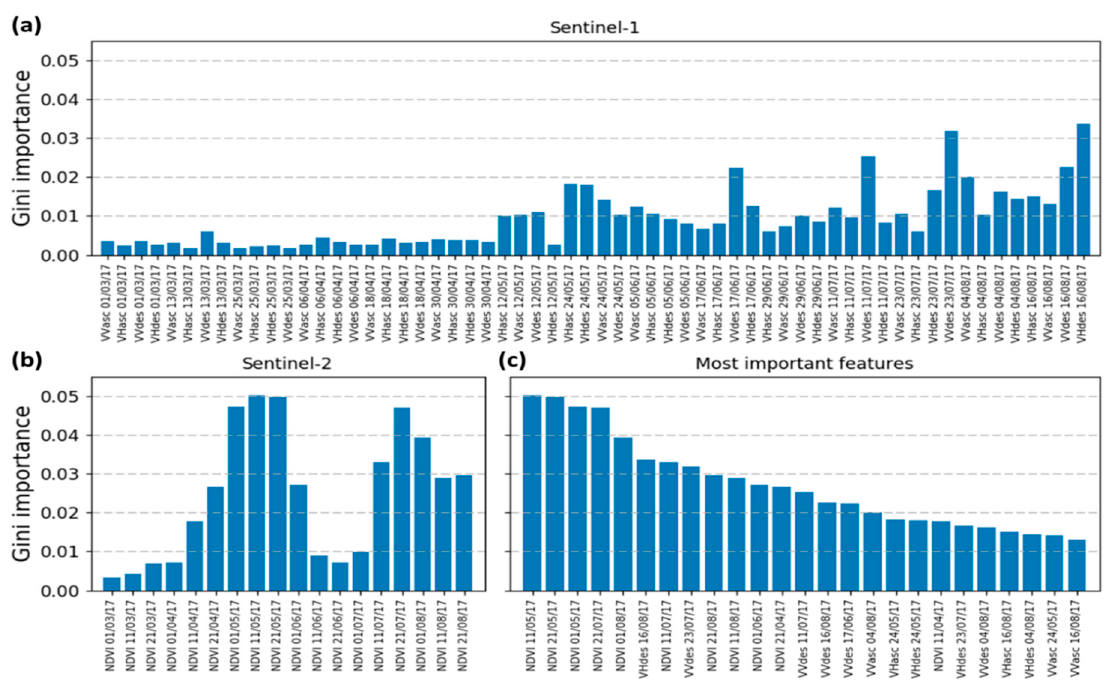
Figure 10. Feature importance defined as the reduction in Gini impurity by that feature. The presented values were extracted from the combined Sentinel-1/Sentinel-2 classification step in the hierarchical procedure, in which the different crop types were distinguished. ( a ) Chronologically ordered Gini importance for the Sentinel-1 predictors (asc = ascending pass, des = descending pass). Each date indicates the start of a 12-day period for which the mosaic was created. ( b ) Chronologically ordered Gini importance for the Sentinel-2 NDVI predictors. Each date indicates the start of a 10-day period for which the mosaic was created. ( c ) Twenty-five most important features for the combined Sentinel-1/Sentinel-2 classification.